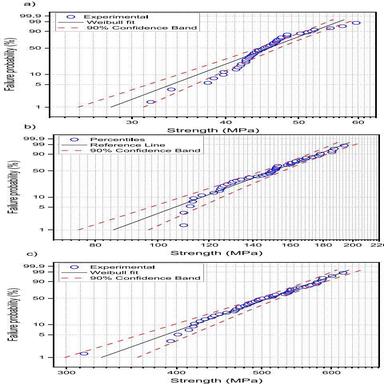
Weibull distributions of the intrinsic strength values calculated from the experimental ones of all thick and thin specimens of each material using Eq. . The corresponding Weibull parameters, summarized in Table 5, are the intrinsic ones for each material. a) PZT. b) Al2O3. c) Si3N4.